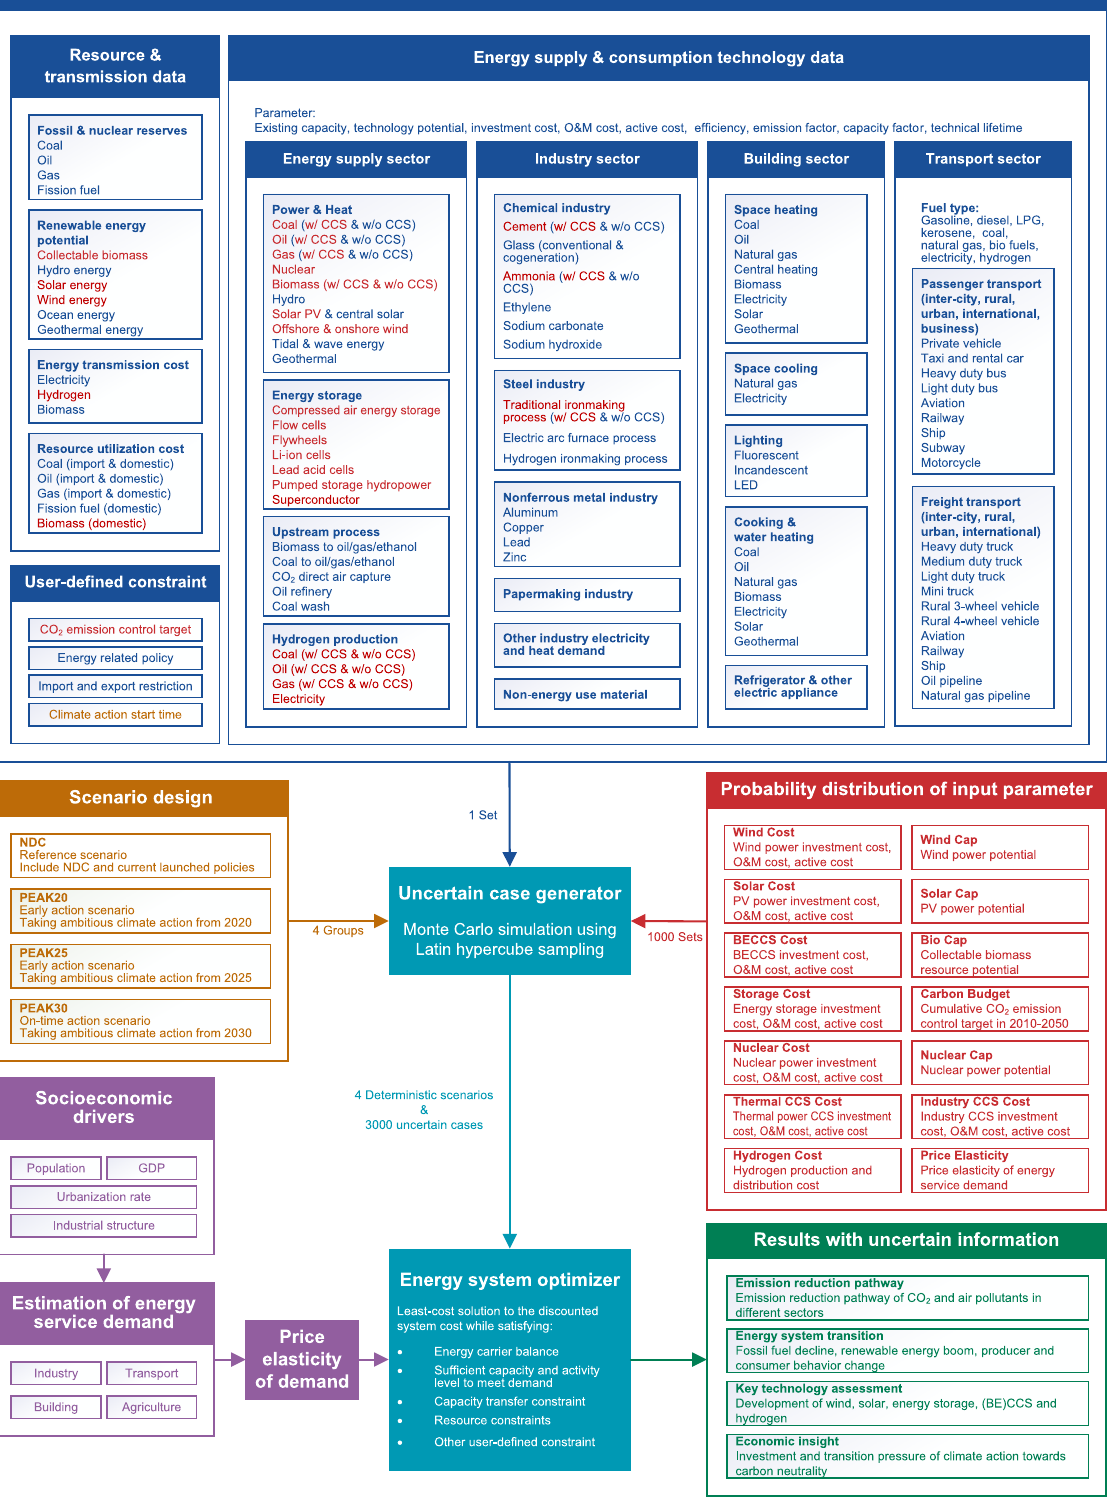
NATURE COMMUNICATIONS| (2022) 13:87